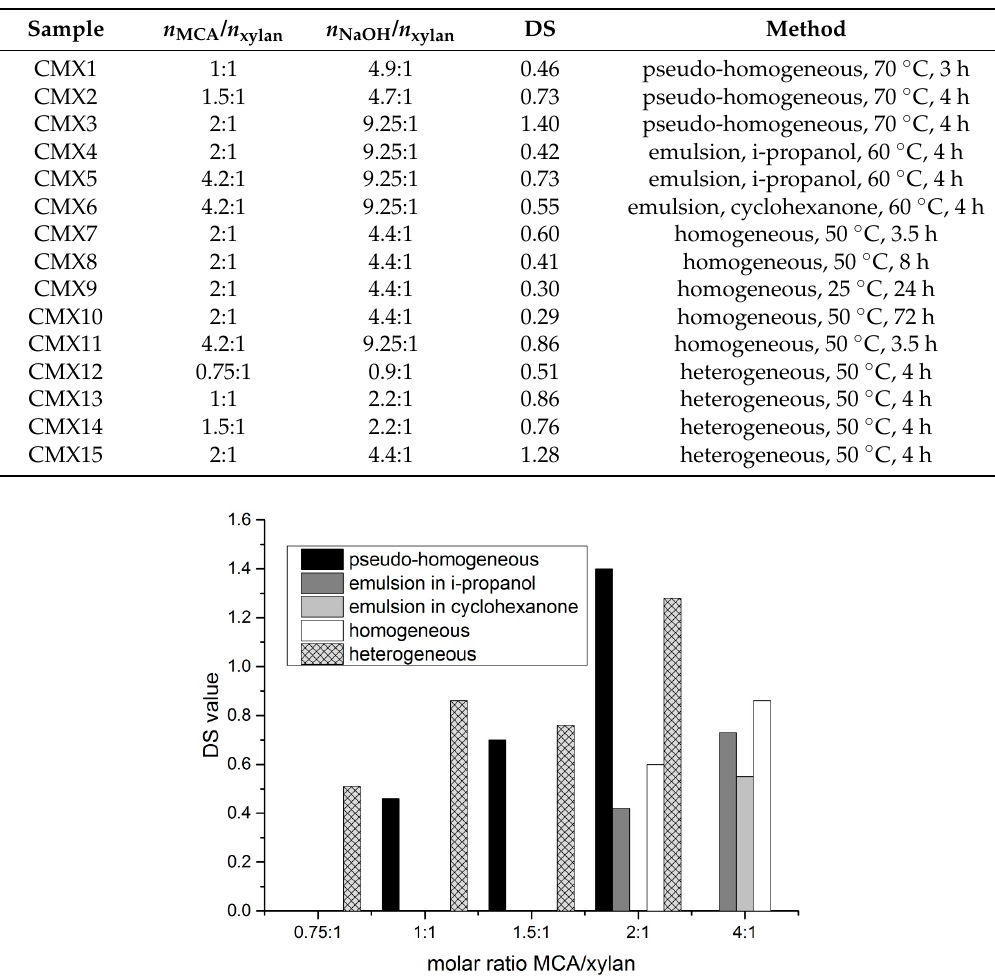
Figure 6. Reaction scheme of the preparation of carboxymethyl xylan. Table 2. Effect of the synthetic procedure on the synthesis of carboxymethyl xylan.